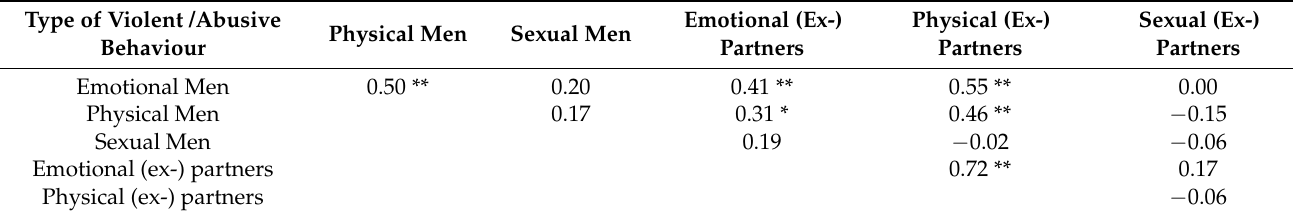
Table 5. Correlations among the number of the three types of violent behaviours of both